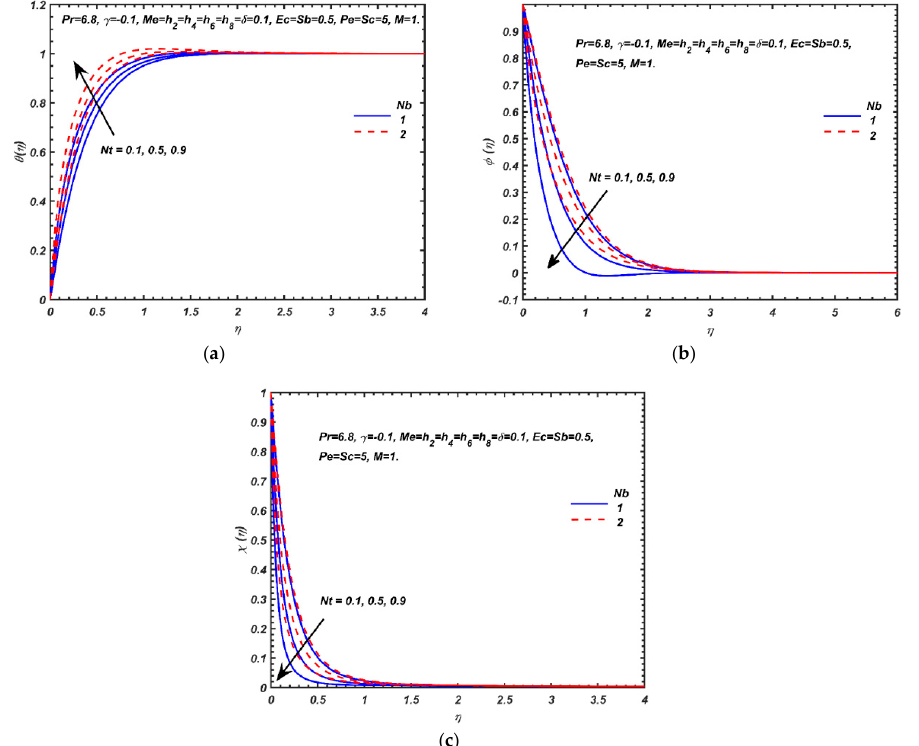
Figure 7. Effects of Nb and Nt on the dimensionless ( a ) temperature, ( b ) nanoparticle volume fraction and ( c ) micro-organism density number